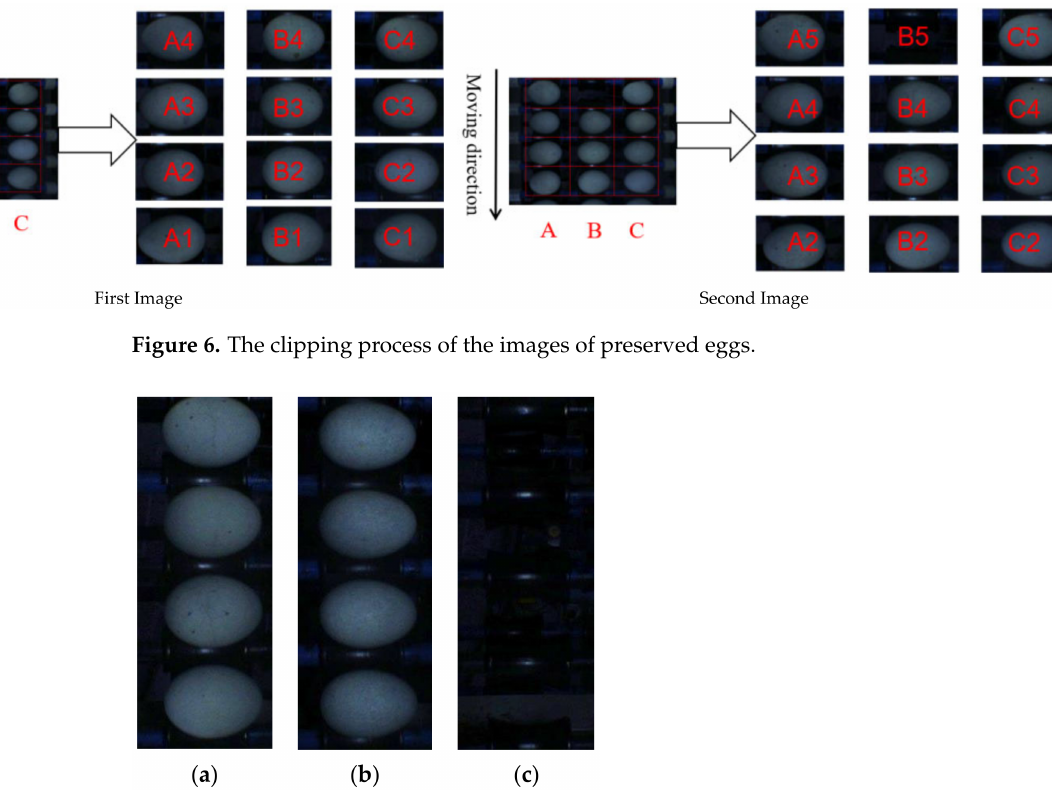
Figure 7. The splicing result of the sequential splicing scheme. ( a ) Cracked preserved egg. ( b ) Preserved egg. ( c ) Vacancy.